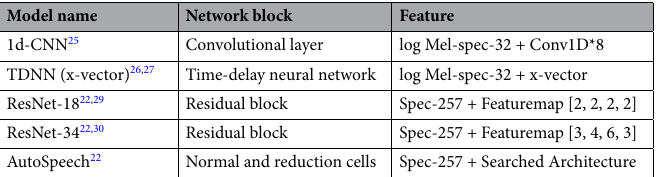
Table 2. The details of open-source research products on voice biometric. log Mel-spec log Mel-spectrogram, Spec spectrogram